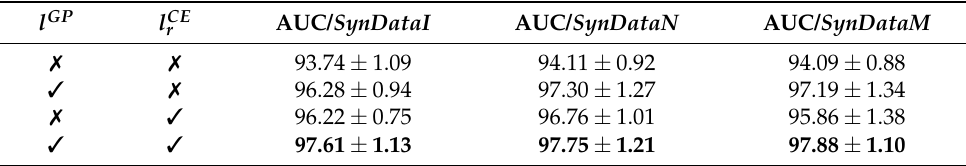
Table 3. AUC performance of the GPGDA algorithm when the update gradient flows from l GP and l CE r are enabled or disabled.